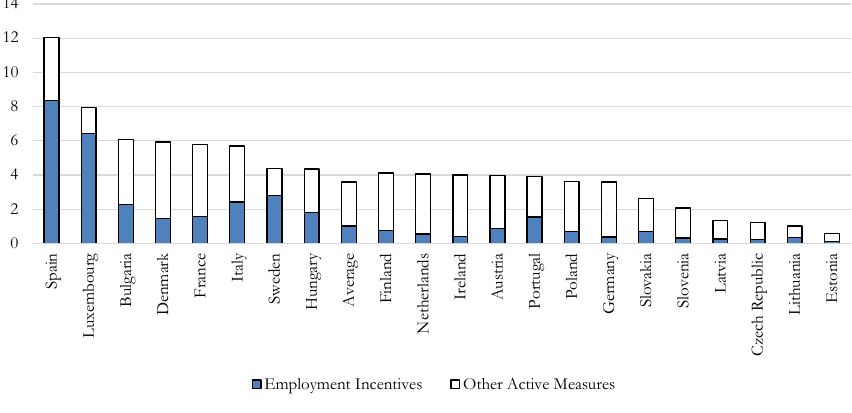
Fig. 2 – Participants stocks to ALMPs, 2007 – 2015, % of labour force. Source: Eurostat (2017).